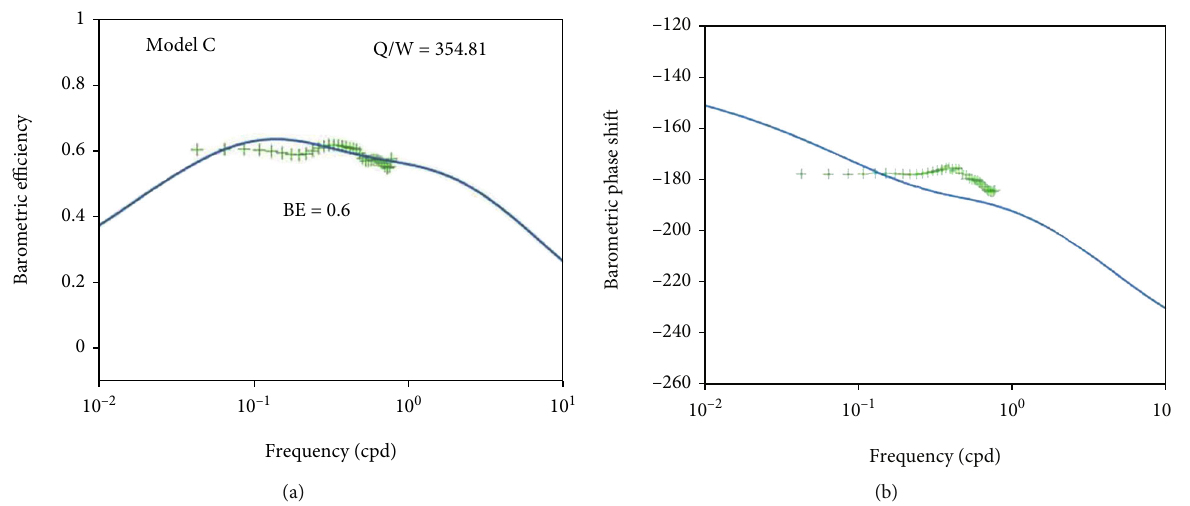
Figure 7: Fitting the (a) actual gain (barometric e ffi ciency)- ω and (b) phase- ω curves calculated from the observed data of water level and barometric pressure with model C [17]. ∗ In order to be in accordance with the result of Rojstaczer [15], the same as done by Zhang et al. [13], we reduced 180 degrees in the barometric phase